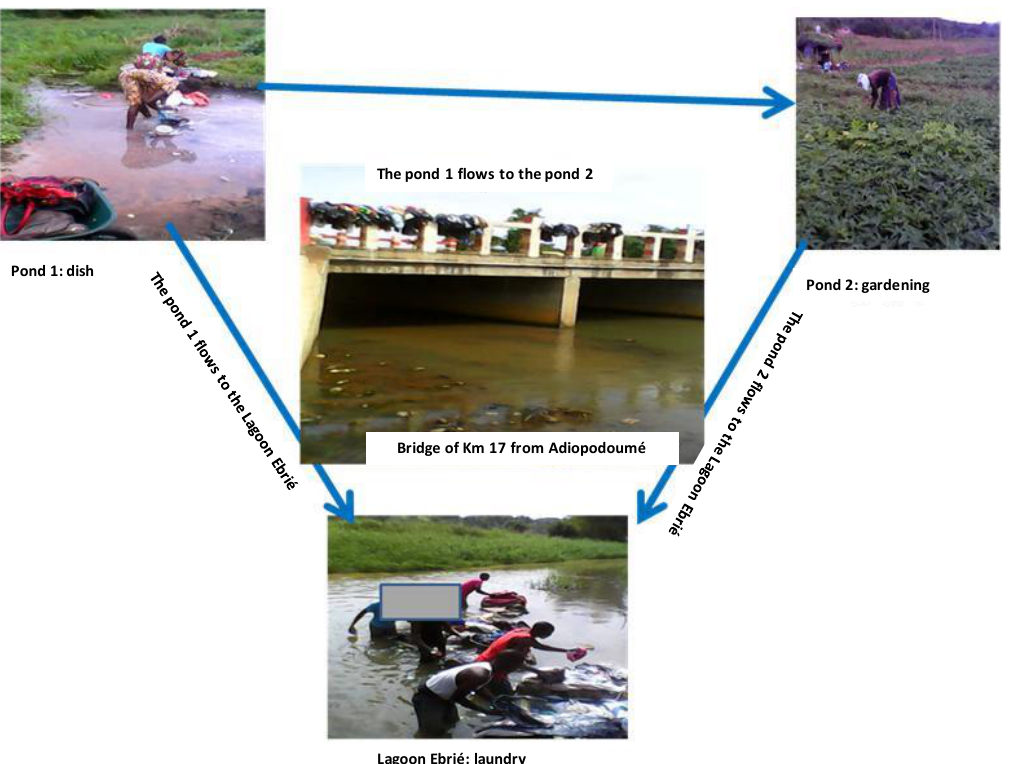
Figure 2. A proposed ecosystem of mycolactone producing mycobacteria in Adiopodoumé. Three water bodies (pond 1, pond 2 and Ebrié lagoon), frequently used by the community of Adiopodoumé for washing dishes, laundry, and gardening activities, were selected for the study. Pond 1 flowed into pond 2 and they both ran to Ebrié lagoon through the Adiopodoumé Km 17 Bridge. These environmental water bodies represent potential sources of infection by mycolactone producing mycobacteria (MPMs). The transmission of MPMs to humans could occur by direct contact with contaminated environmental samples through skin microtraumatism.